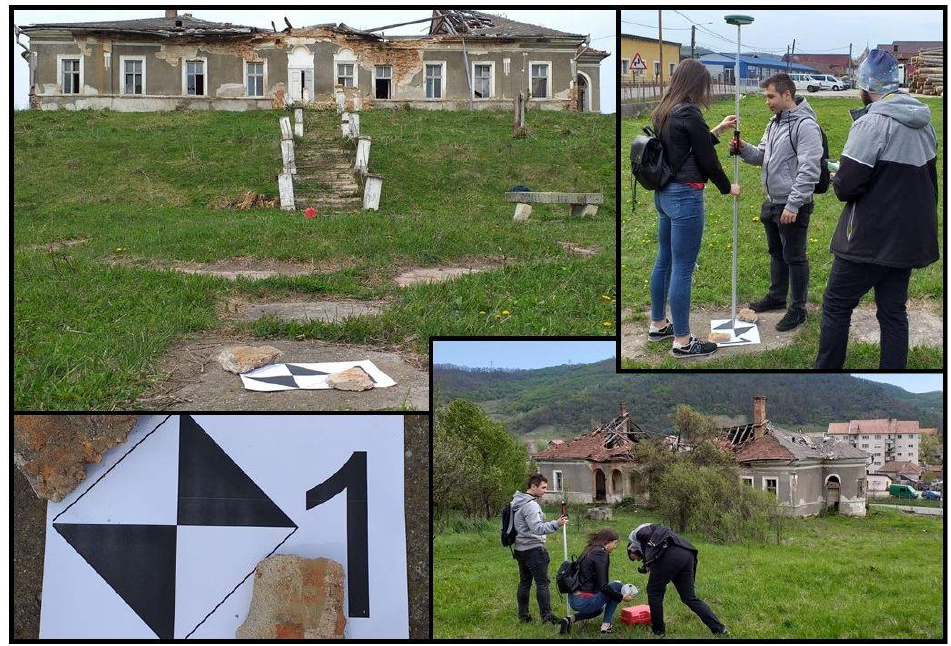
Figure 5. GCPs and CPs GNSS RTK measurement.